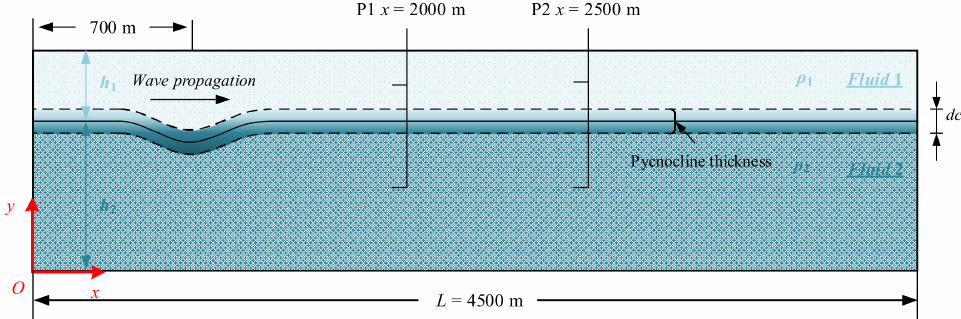
Figure 5. Boundary condition and schematic diagram of the probe